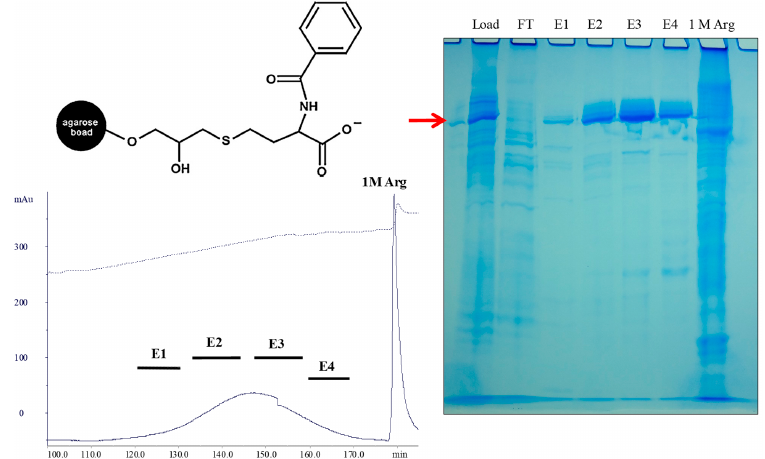
Figure 10. Purification of mouse monoclonal antibody using Capto MMC. Inset, structure of Capto MMC. Conditioned medium expressing a mouse antibody was loaded onto Capto MMC in PBS and eluted with a linear gradient from 0.3 M NaCl to 0.3 M arginine/0.3 M NaCl in 20 mM phosphate, pH 7.0. SDS-PAGE shows load, FT, eluted fractions of E1–E4 and final 1 M arginine (1 M) wash at pH 7.0. The arrow indicates the antibody band.